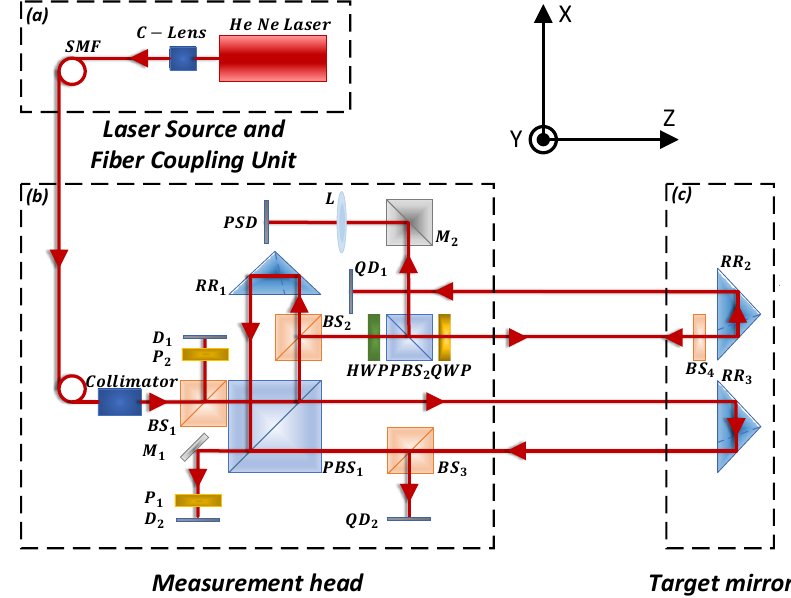
Figure 2. Configuration of the simultaneous measurement system for 6DOF errors on a linear axis.